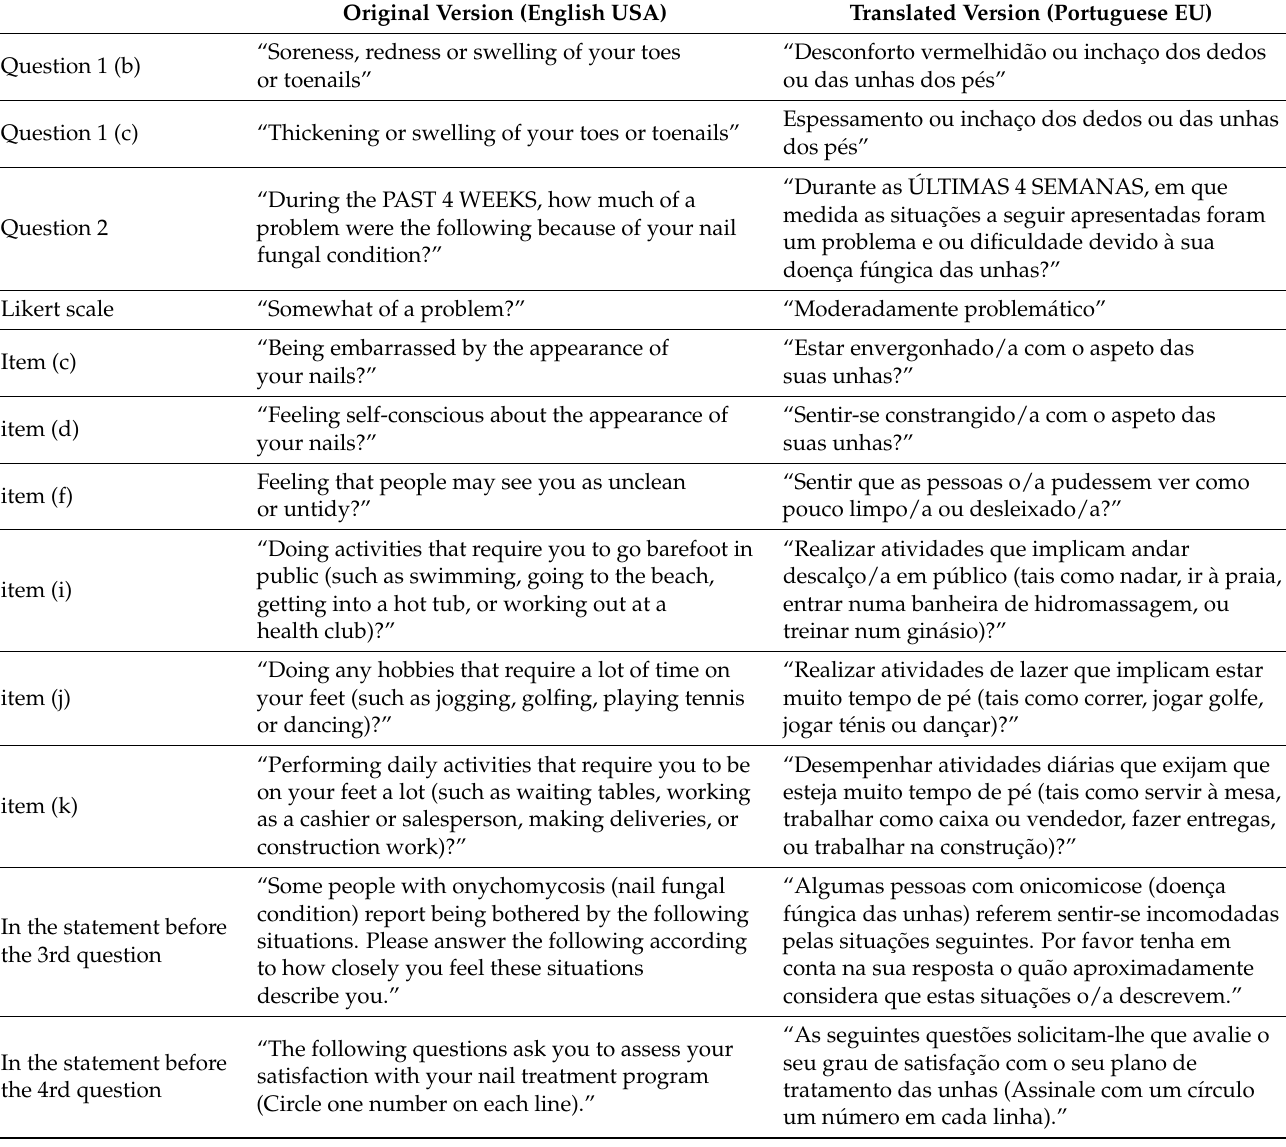
Table 3. The original and translated proposed version of the OnyCOE-t TM